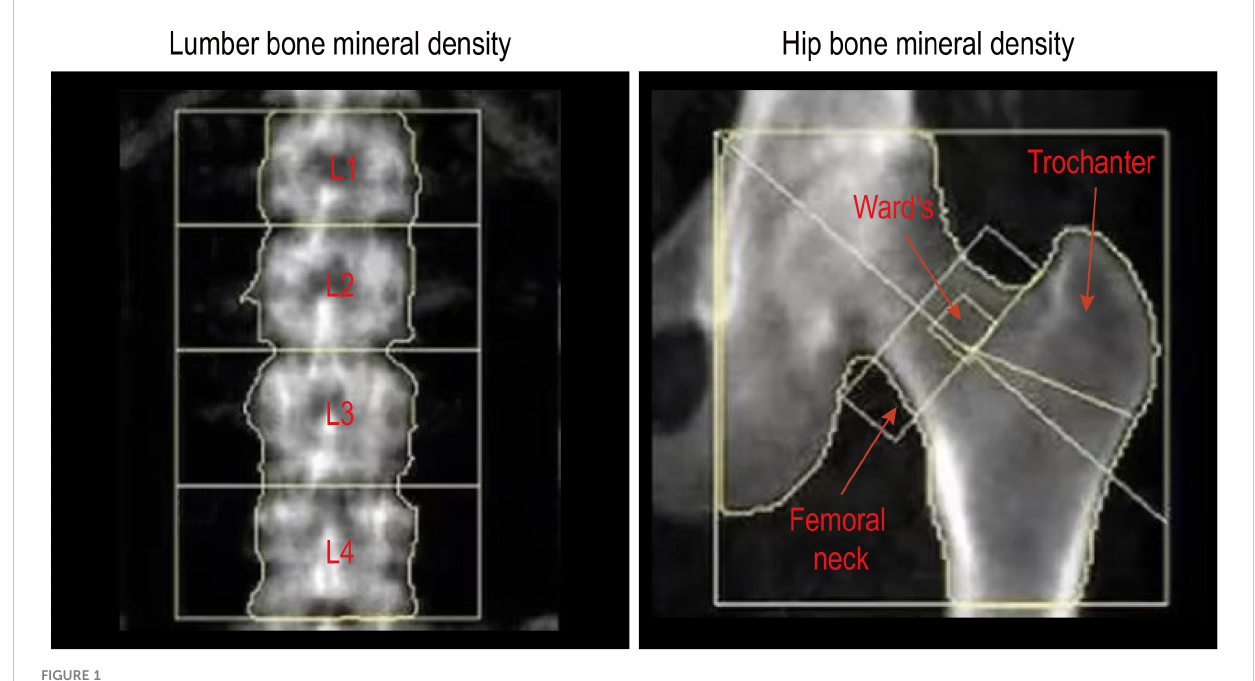
FIGURE 1 The assessment of bone mineral density in the lumbar spine and